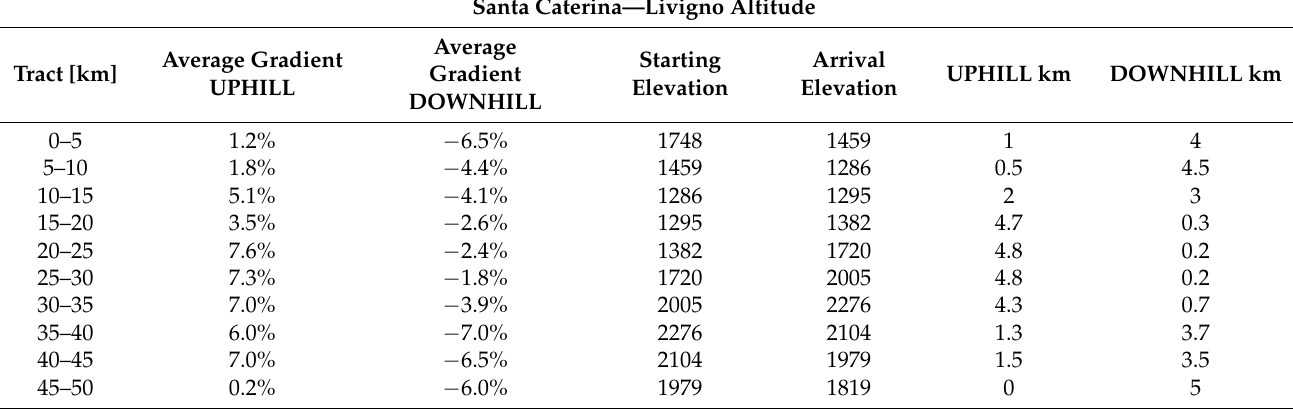
Table 1. Route characteristics.